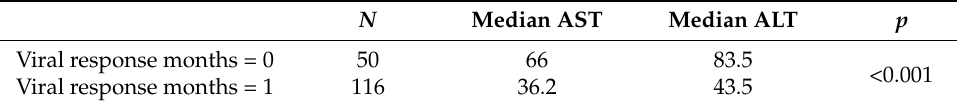
Figure 1. Distribution of the study group according to cytolysis enzyme values. ALT: alanine aminotransferase; AST: aspartate aminotransferase. Table 2. Evaluation of cytolysis enzymes.